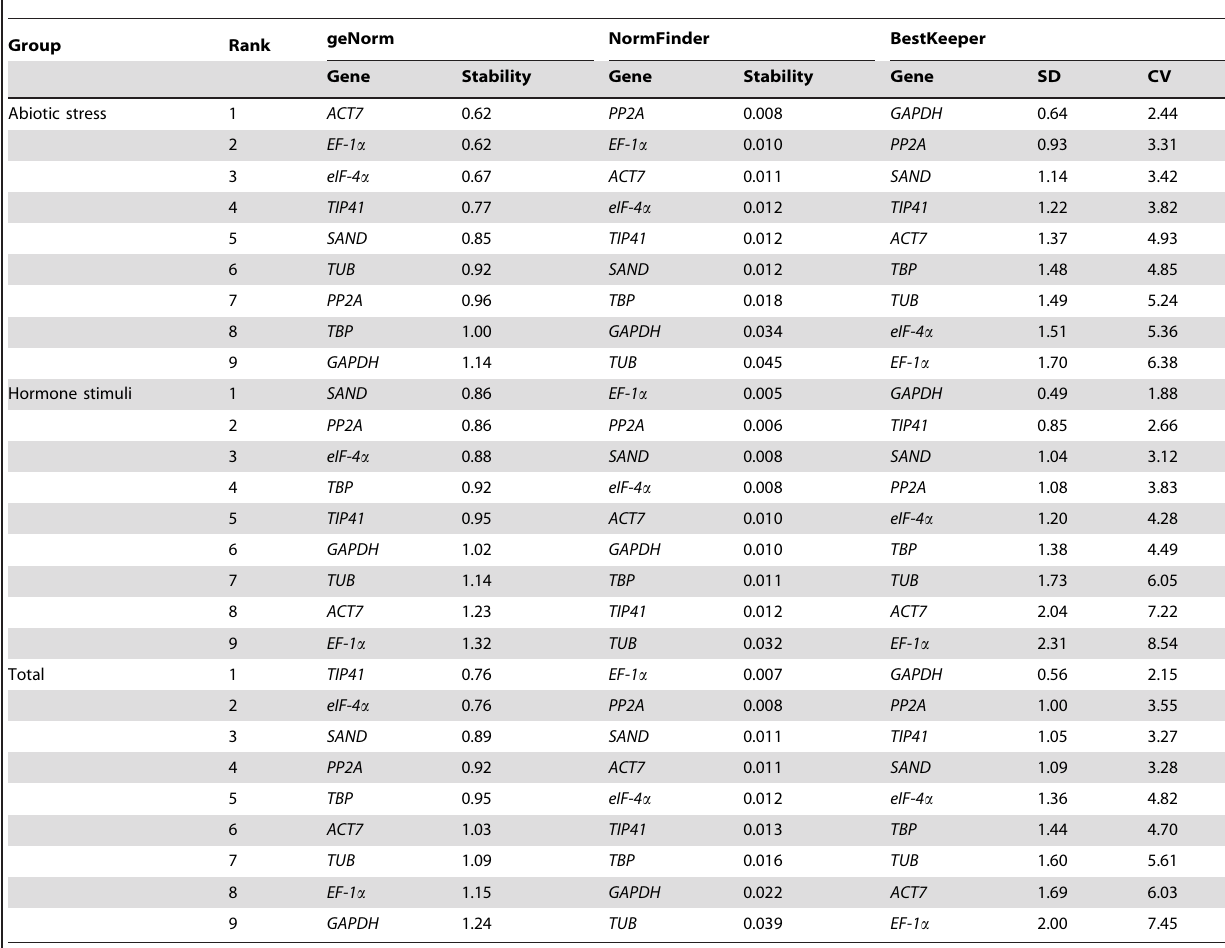
Table 3. Gene expression stability under multiple stress ranked by geNorm, NormFinder and BestKeeper.